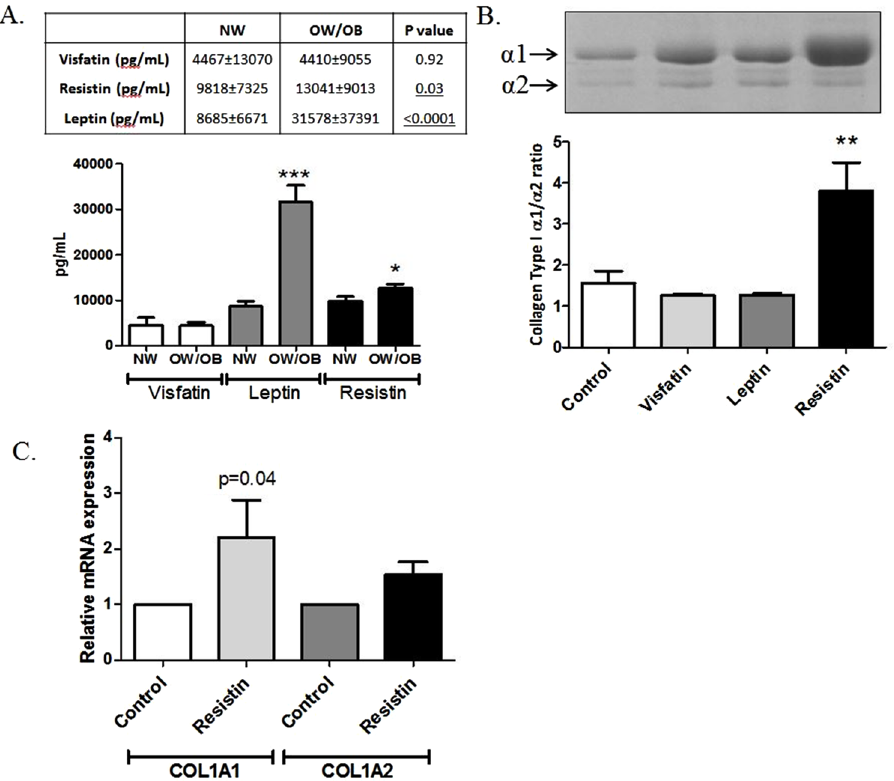
Figure 2. Resistin pathologically alters normal-weight OA bone collagen composition. ( A ) Serum adipokine protein expression in NW (n = 38) and OW/OB (n = 112) patients with OA as determined by Luminex analysis. Values in table represent mean pg/ml ± stdev. Bars in graph represent mean ± SEM. *** p < 0.0001, * p < 0.05. ( B ) The type I collagen α / α 2 ratio in femoral head subchondral bone explants from NW OA patients following stimulation for 4 weeks with either resistin (500 ng/ml), leptin (100 ng/ml), visfatin (500 ng/ml) or media control. Bars represent mean ± SEM (n = 4). The ratio of α 1/ α 2 isoforms was quantified by SDS PAGE analysis. Gel image is a representative coomassie-stained gel of subchondral bone explants after 4 weeks of adipokine stimulation. ( B ) The mRNA expression of COL1A1 and COL1A2 following acute (24 h) stimulation of primary hip OA osteoblasts with either resistin (500 ng/ml) or media control. Expression was determined by Sybr Green qRT-PCR, normalised to ACTB. Bars represent mean ± SEM (n =